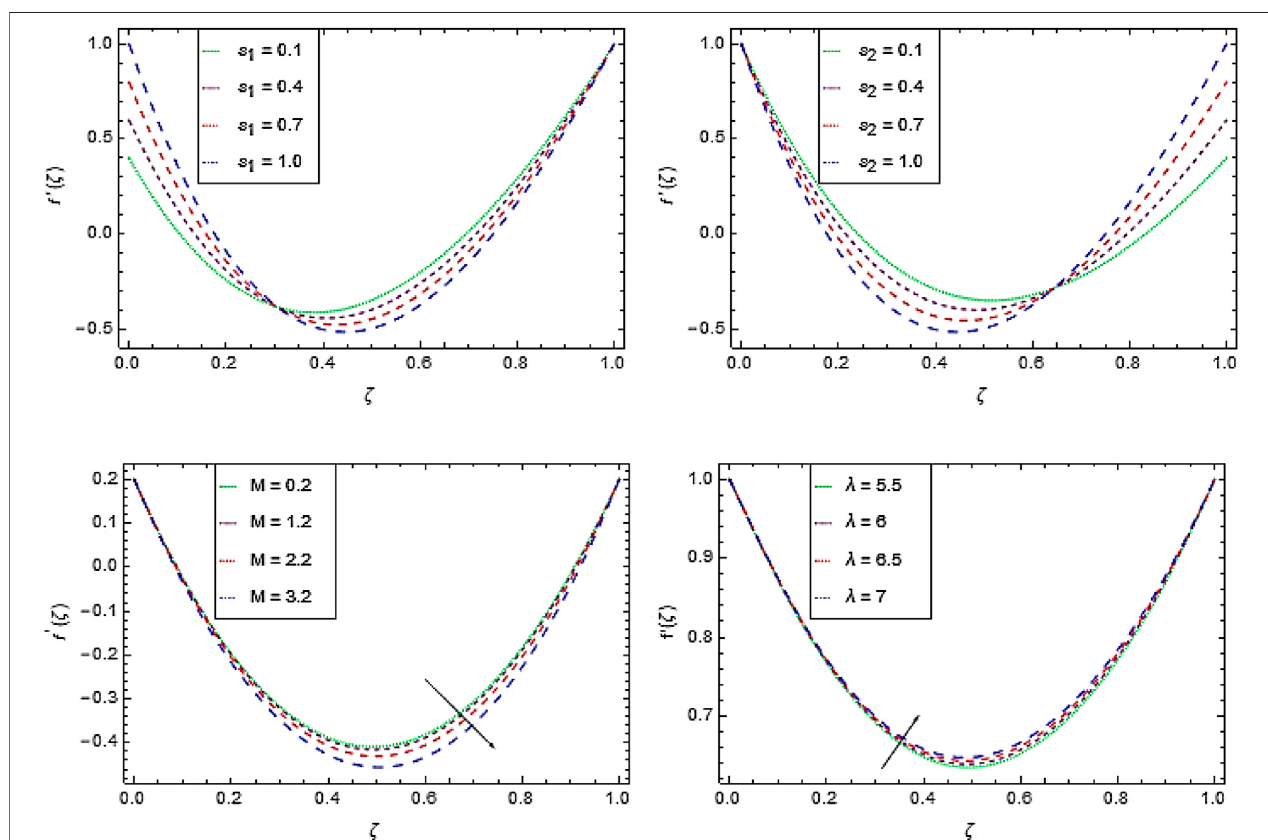
FIGURE 2 | f ′ ( ζ ) as a function of (A) s 1 , (B) s 2 , (C) , and M (D) λ